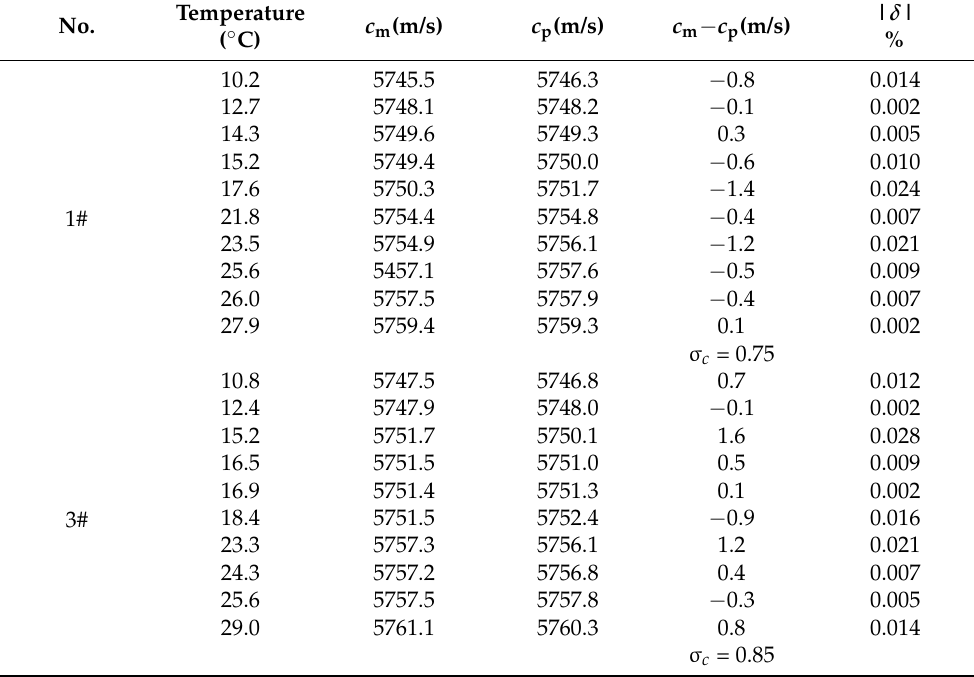
Table 3. Experimental data from the model validation and their error